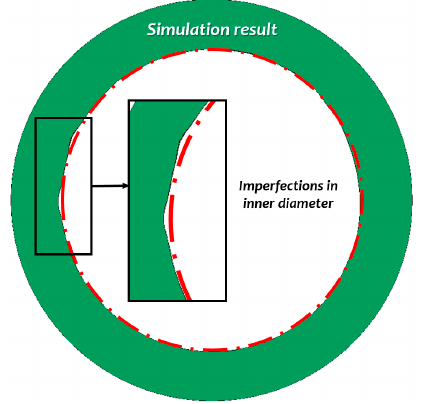
Figure 12. Imperfections in the inner diameter.